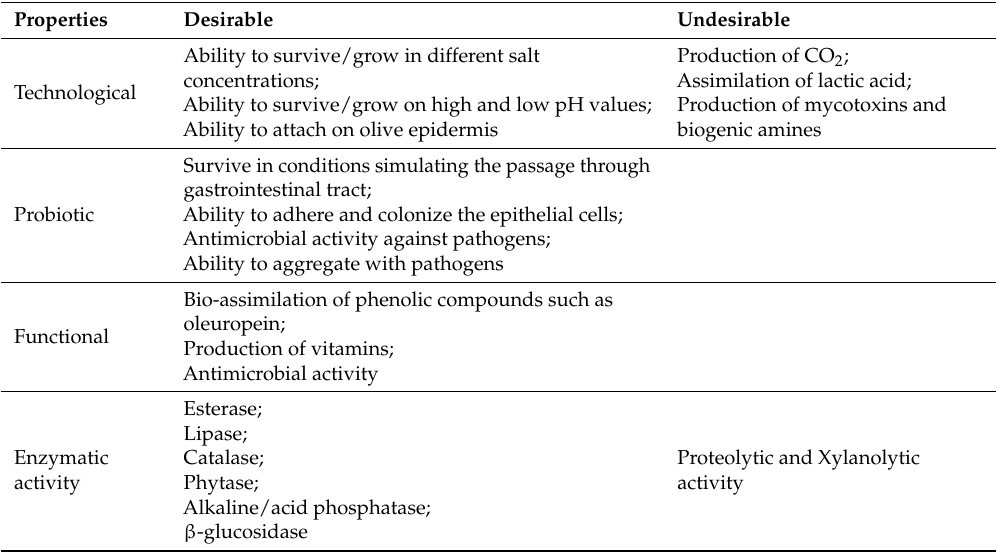
Table 2. Desirable and undesirable characteristics of microorganisms used as starter